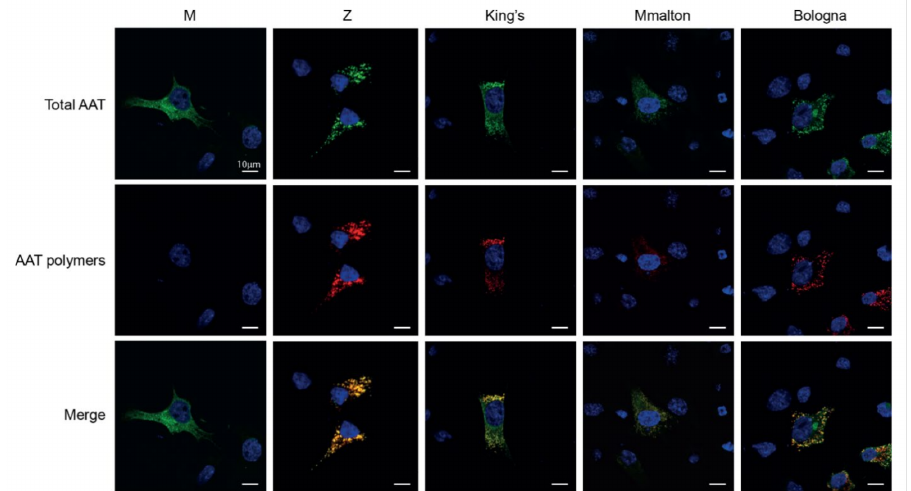
Figure 4. Mutant variants of AAT accumulate intracellularly as 2C1-positive polymers. Hepa 1.6 cells seeded on glass coverslips were fixed 48 h after transfection with the indicated AAT variants. After permeabilization, cells were immunostained with an anti-human AAT polyclonal Ab (Dako) (green) or with the anti-AAT polymers 2C1 mAb (red). Merged panels are shown with overlapping signals in yellow. Nuclei were stained blue by the Hoechst dye. Cells expressing Z, King’s, Mmalton and Bologna AAT variants showed a punctate pattern of 2C1-positive polymers. Scale bar in all panels is 10 µ